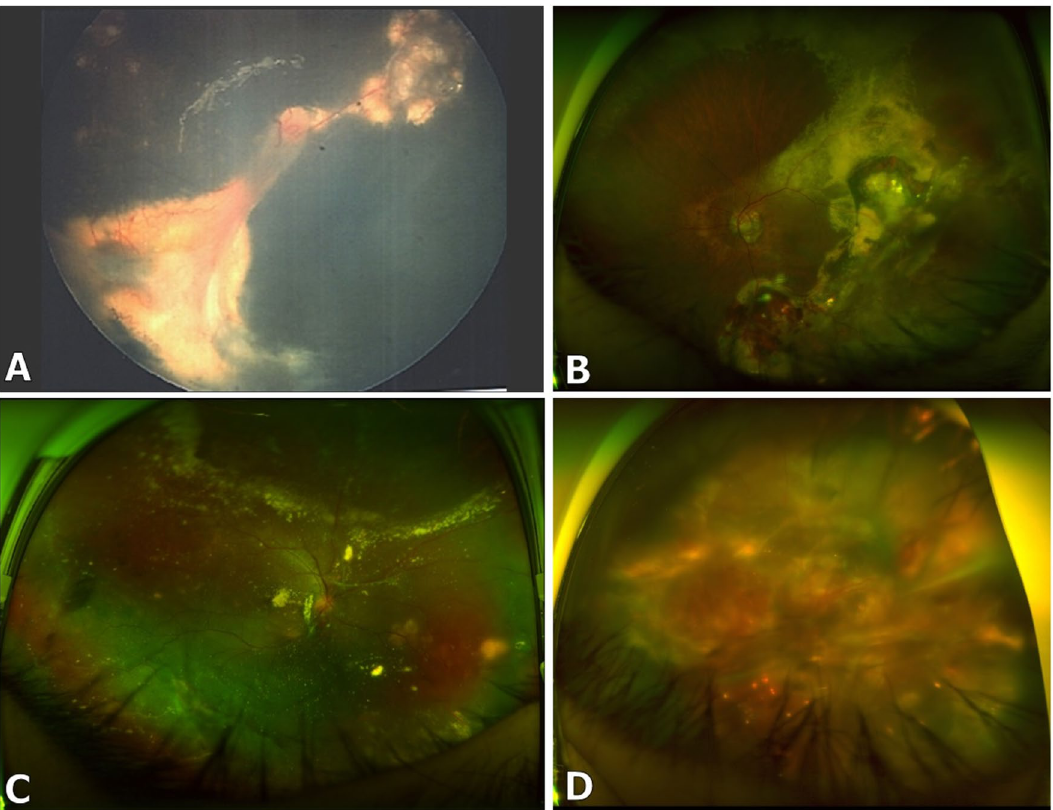
Figure 2. Tractional retinal detachments in Coats’ disease. Patients may develop tractional detachments during long-term follow-up after treatment with cryotherapy ( A ), laser ( B ), or laser combined with anti-VEGF injections ( C , D ).